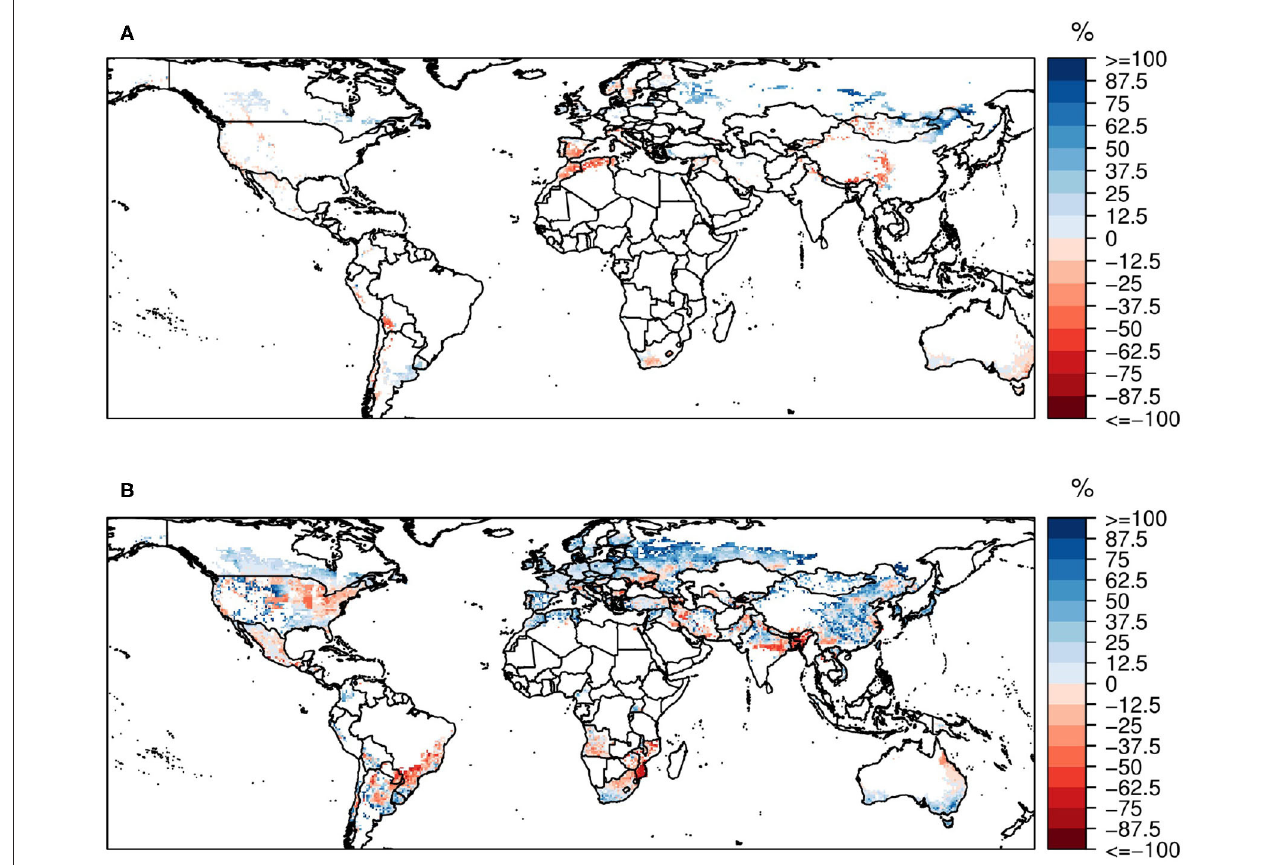
FIGURE 4 | Yield percentage change from baseline climate to 2040–2060. Values shown are mean values across climate models. (A) Non-adaptation simulations. (B) Adaptation to future